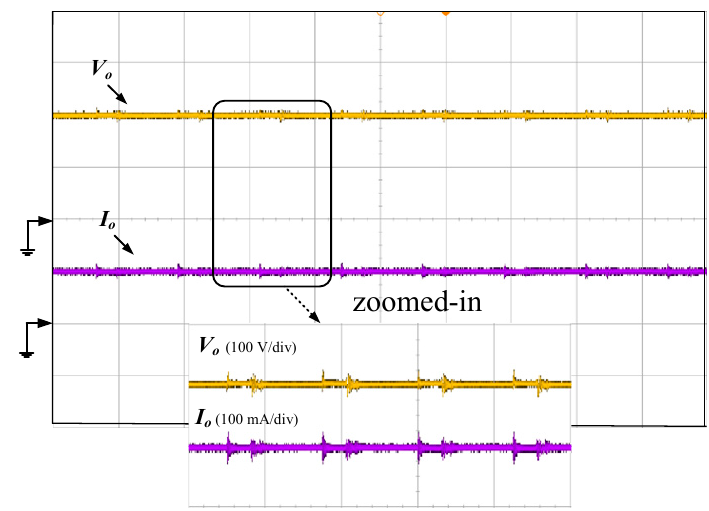
Figure 17. The measured waveforms of the control signal, output voltage, and input current while input 1 encounters power failure.